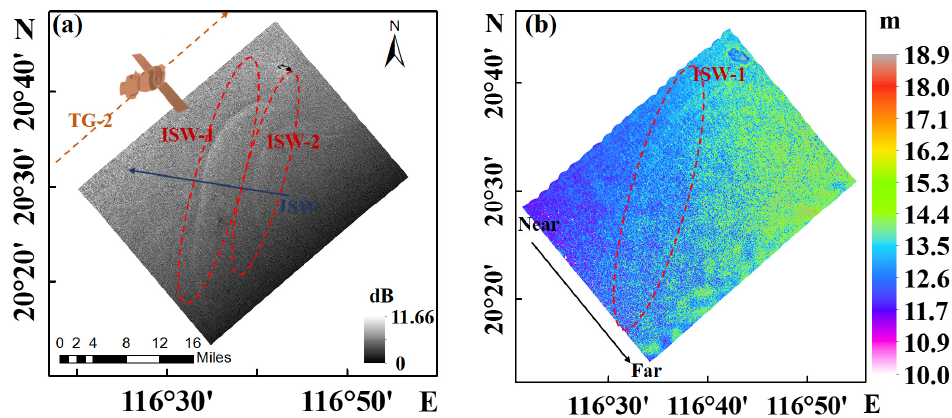
Figure 6. The InIRA images featuring ISWs acquired in SCS on 23 September 2016: ( a ) L2 image, the blue solid lines signify the propagation direction of ISWs, while the yellow dashed lines show the flight direction of Tiangong-2; ( b ) L4 image, ISWs features are in the red